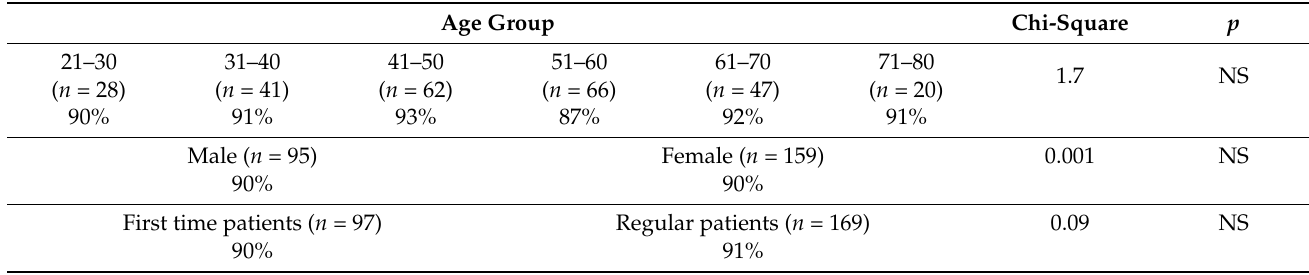
Table 4. Patients’ knowledge about the influence of periodontitis on general health status.